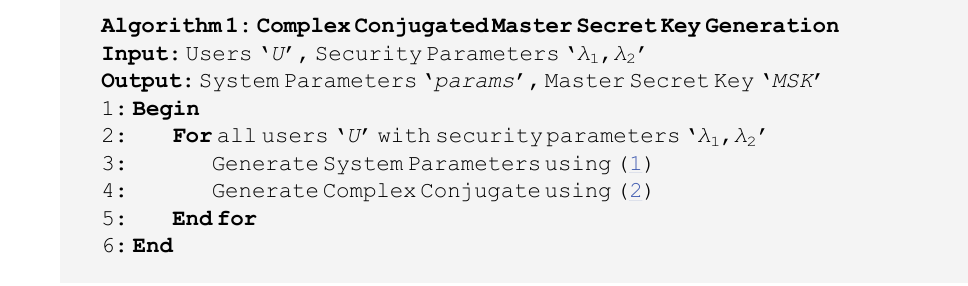
Algorithm1: ComplexConjugatedMaster Secret Key